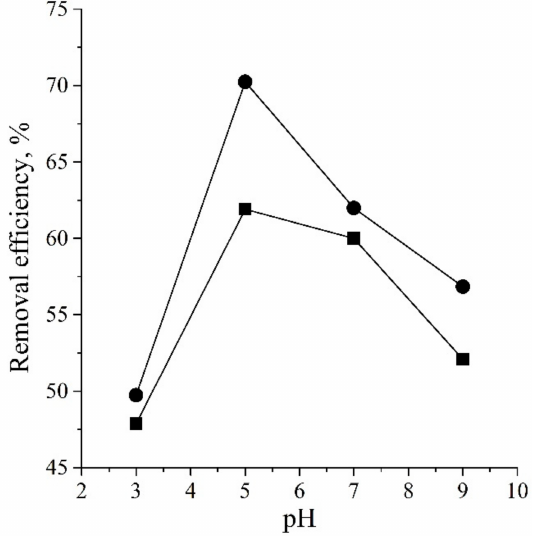
Figure 7. The influence of pH in the CIP adsorption on CLI (squares) and MAG-CLI (circles);